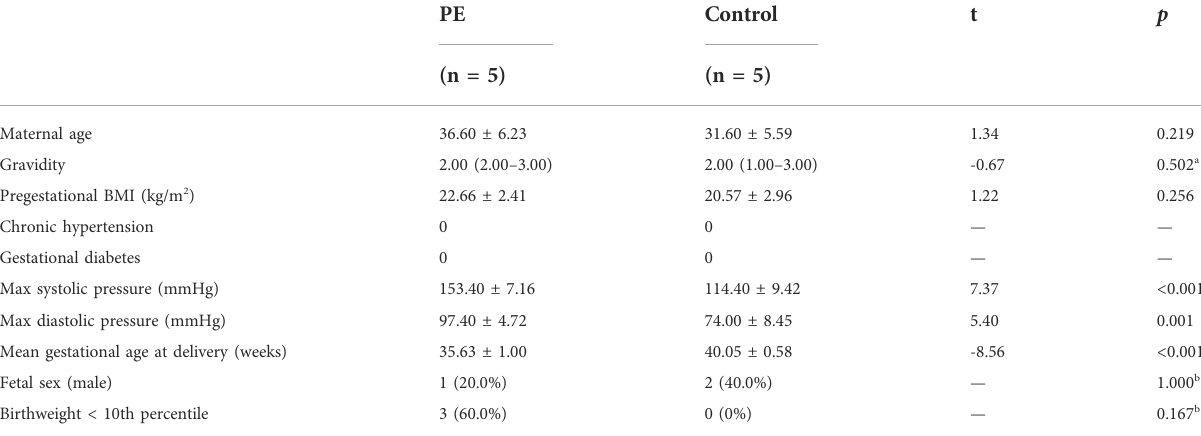
TABLE 1 Maternal demographic characteristics and infant